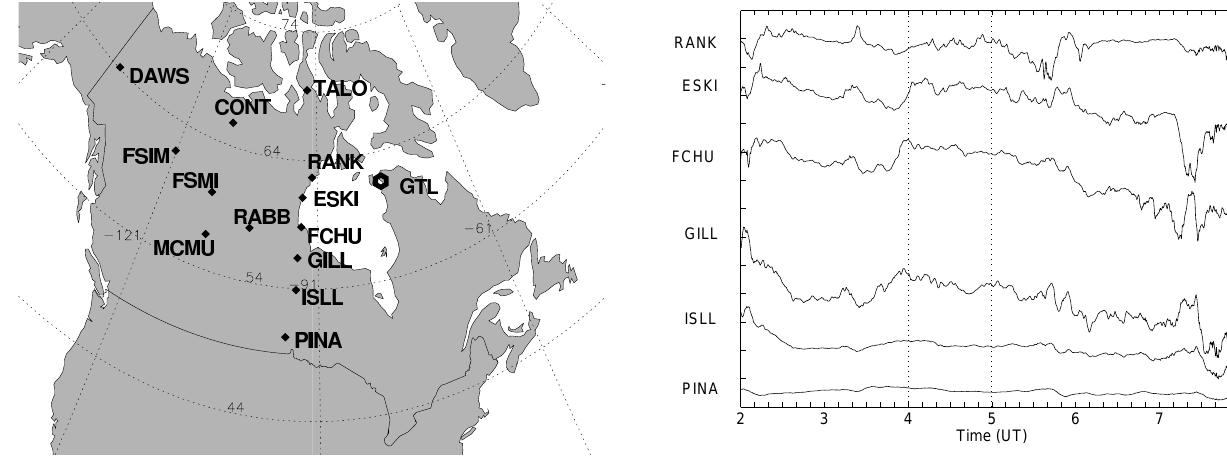
Fig. 1. CANOPUS magnetometer stations on a geographical coor- dinate system grid (cf. Rostoker et al., 1995).